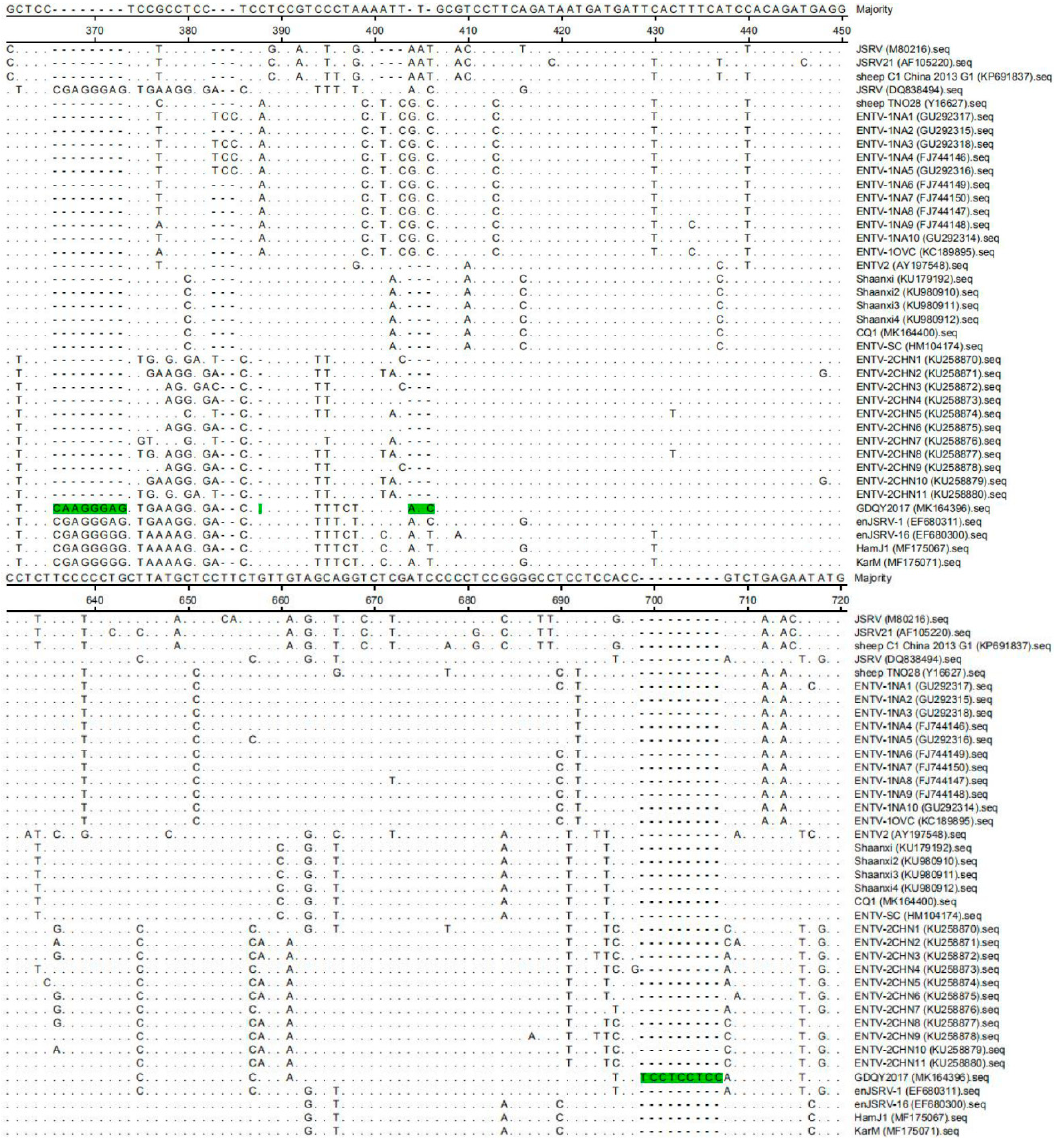
Figure 3. Multiple sequence alignment results of the gag gene of ENTV-2 with ENTV-1, jaagsiekte sheep retrovirus (JSRV), and endogenous JSRV (enJSRV). The nucleotide insertion sites in the gag gene of GDQY2017 were marked with green color.